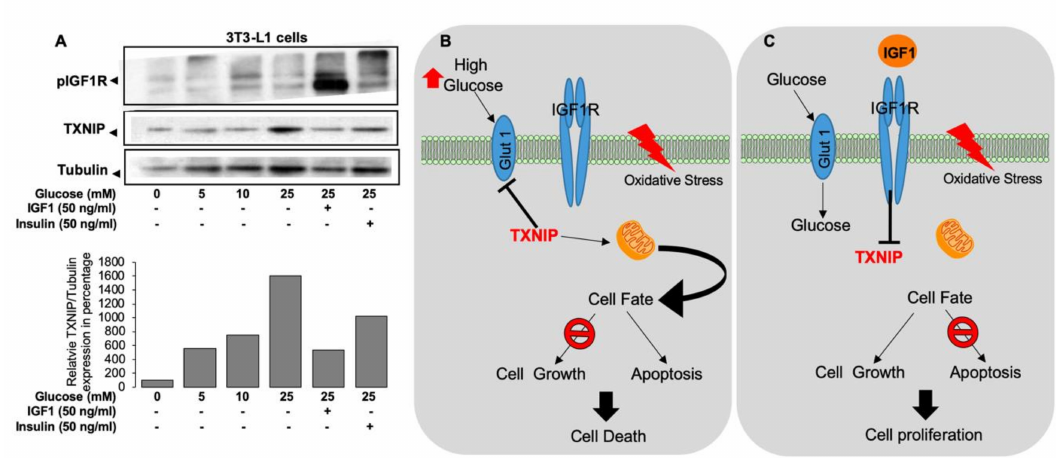
Figure 5. E ff ect of glucose stress on TXNIP levels [79]: ( A ) Serum-starved 3T3-L1 cells were maintained in medium with di ff erent concentrations of glucose in the presence or absence of IGF1 or insulin for 6 h. TXNIP, phospho-IGF-1R, and tubulin were detected by Western blotting. Schematic representation of the regulation of TXNIP by IGF1 signaling: ( B ) Under normal serum-free conditions, TXNIP is upregulated upon oxidative and glucose stresses. The activated TXNIP inhibits glucose uptake and is capable of mediating mitochondrial mediated apoptosis. ( C ) Upon IGF1 stimulation, TXNIP is downregulated even under oxidative and glucose stresses. Suppression of TXNIP leads to inhibition of apoptosis with ensuing increase in cell